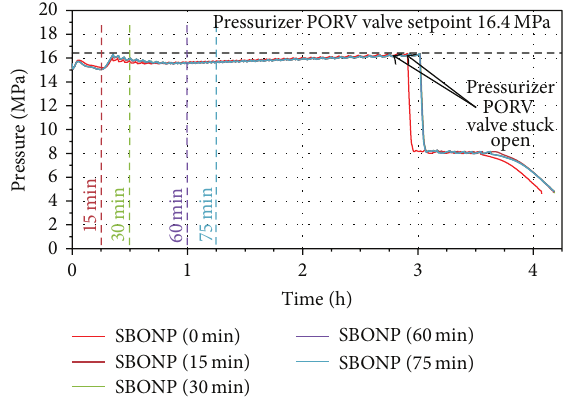
Figure 5: Pressurizer pressure, SBONP case scenarios.